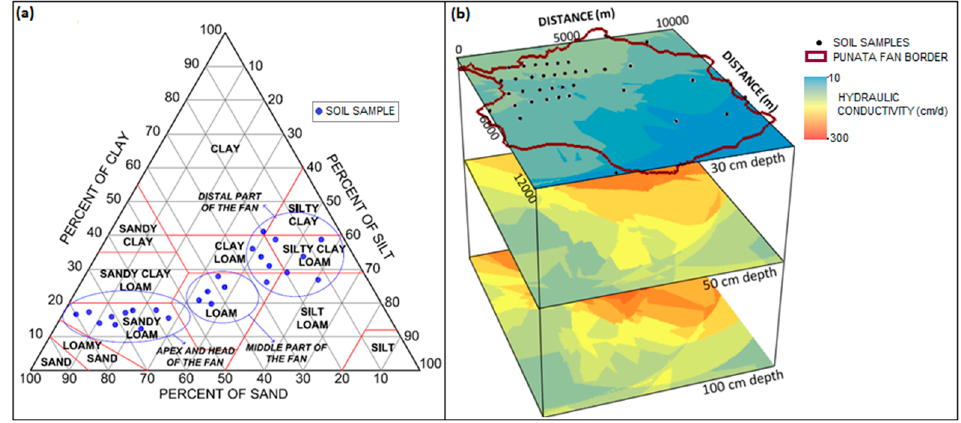
Figure 2. ( a ) Classification of soil texture by percentage of clay, sand and silt; ( b ) Spatial variation of hydraulic conductivity at depths of 30, 50 and 100 cm.